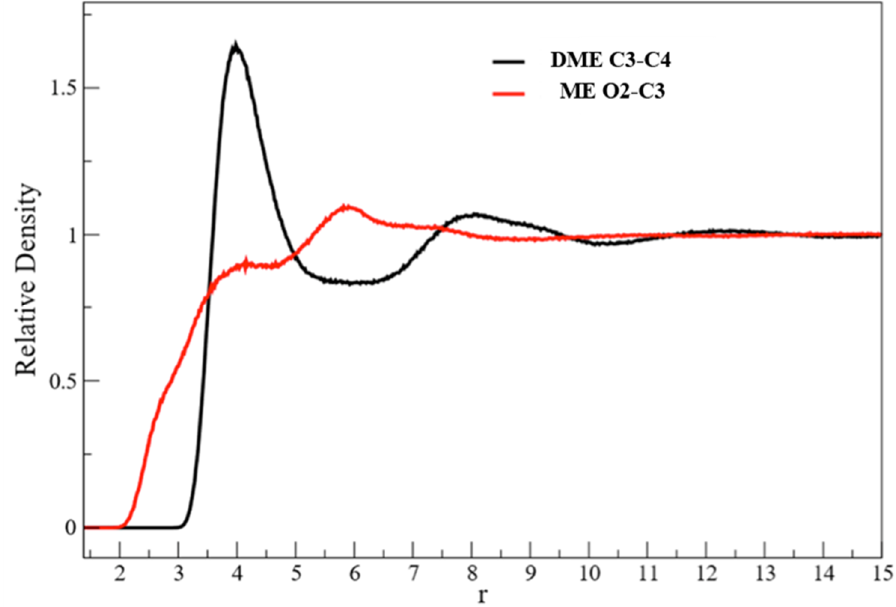
Figure 8. ME and DME hydrogen-methyl and methyl-methyl distribution function.